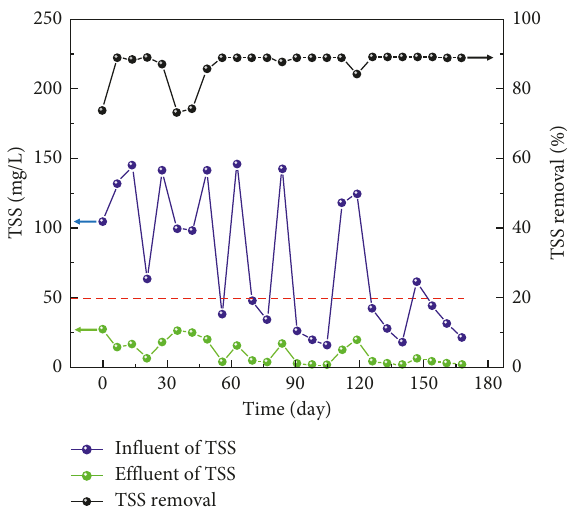
Figure 5: TSS removal during the experimental period.